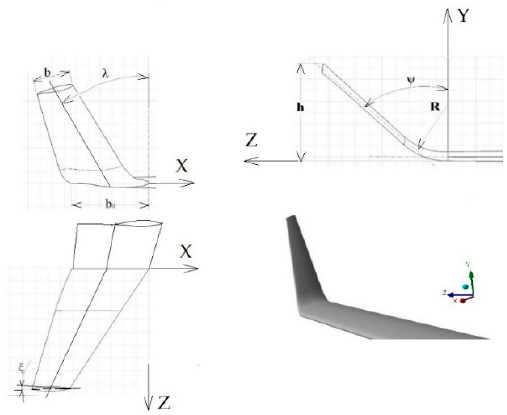
Figure 9. Geometrical parameters of a typical Whitcomb winglet.